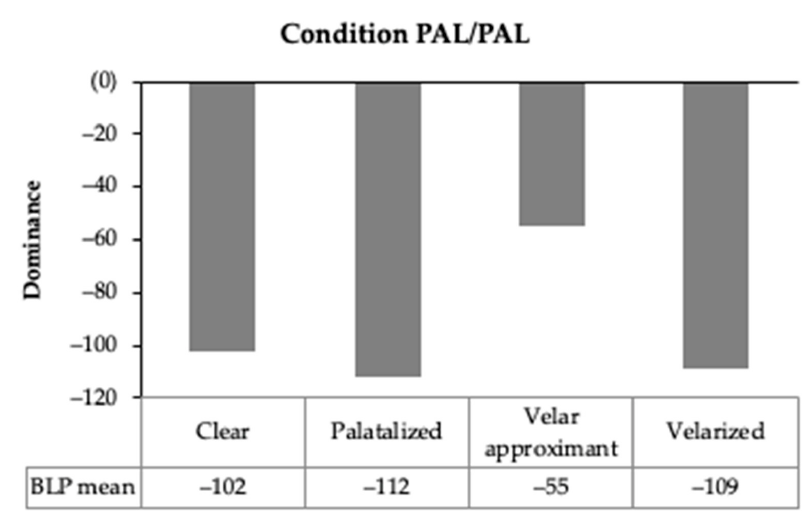
Figure 7. The interaction effect of condition VEL/VEL and language dominance.